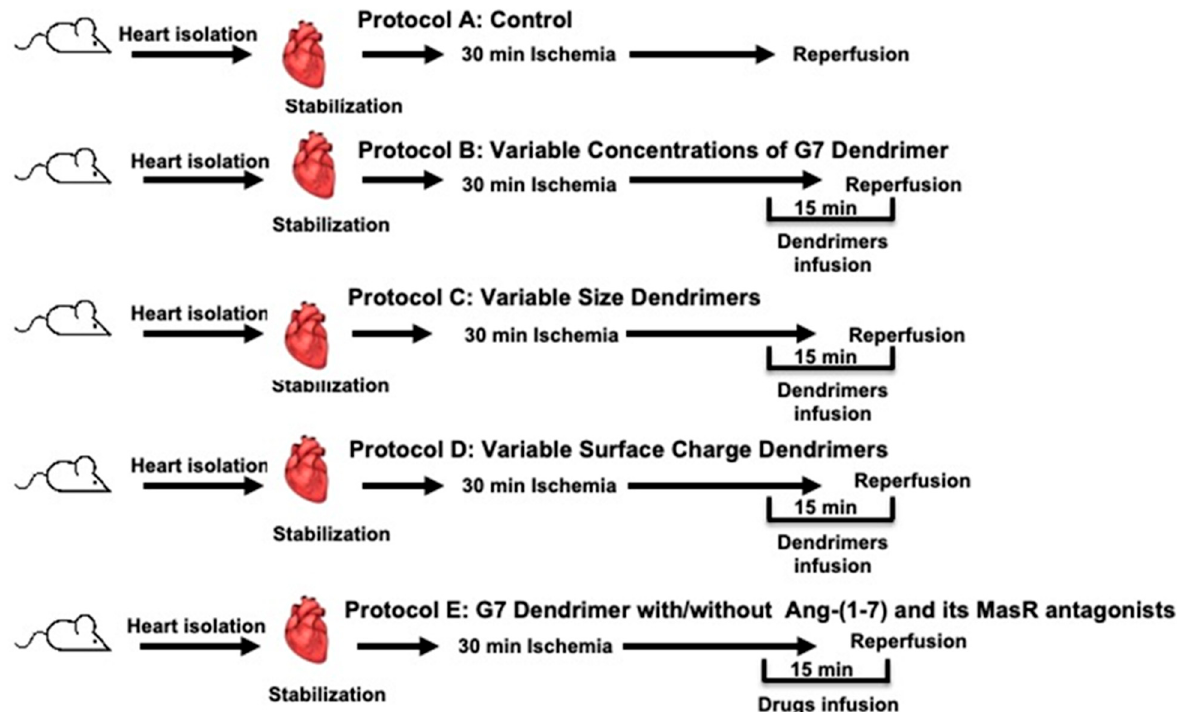
Figure 1. Schematic representation showing the experimental protocols used in the study (n = 8). A: Untreated ischemia-reperfusion control (C). B: Dose response relationship for the G7 PAMAM dendrimer. C: Effect of the dendrimer size (generation) on heart subjected to ischemia and reperfusion. D: Effect of the surface charge/chemistry of dendrimers on hearts subjected to ischemia and reperfusion. E: Effect of the G7 PAMAM dendrimer in the presence or absence of Ang-(1-7) and its Mas receptors antagonists on the effects of ischemia and reperfusion.